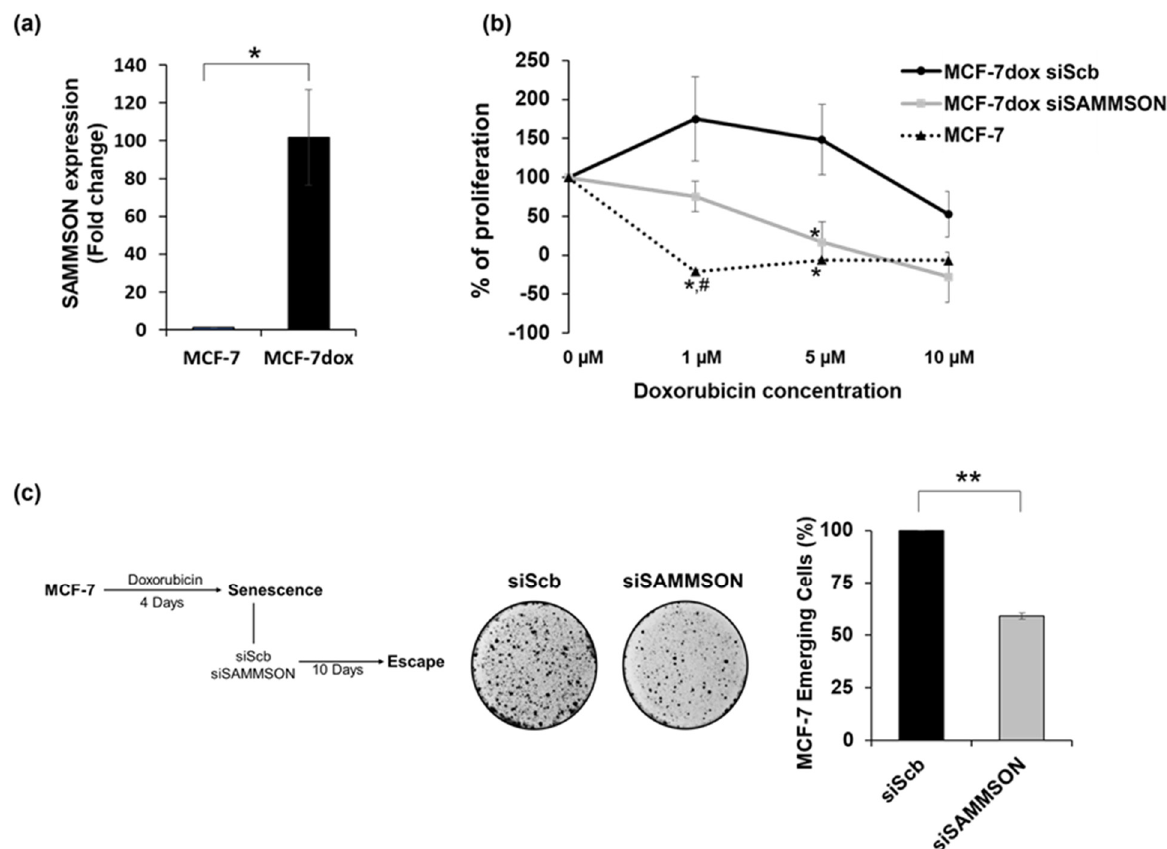
Figure 1. Expression and involvement of SAMMSON in the resistance of MCF-7dox cells to doxorubicin and in the senescence escape of MCF-7 cells after doxorubicin treatment. ( a ) RT-qPCR analysis of SAMMSON expression in doxorubicin- sensitive MCF-7 cells (MCF-7) and doxorubicin-resistant MCF-7dox cells (MCF-7dox). The data are represented by the mean ± SEM of n = 4 MCF-7 and MCF-7dox cells. ( b ) Doxorubicin sensitivity of MCF-7 cells (MCF-7) and MCF-7dox after SAMMSON silencing (siSAMMSON) compared to control cells MCF-7dox siScb (siScb). Cells were exposed to different doxorubicin concentrations (0, 1, 5 and 10 µ M) and the number of cells was counted after 48 h and normalized to the number of cells counted at time 0 h. The data are represented by the mean ± SEM of n = 4 for MCF-7 cells and n = 5 for MCF-7dox siScb and siSAMMSON cells. ( c ) Senescence escape in MCF-7 cells treated for 96 h with doxorubicin and then transfected with SAMMSON (siSAMMSON) or Scramble siRNAs (siScb). Cell emergence was evaluated after 10 days. Left panel: representative images of the persistent cell stained with crystal violet; right panel: percentage of emerging cells. The p -values were calculated using the Mann–Whitney test; # indicates a significant difference compared to MCF-7dox siSAMMSON (# p < 0.05) and * indicates a significant difference compared to MCF-7dox siScb (* p < 0.05, ** p < 0.01).